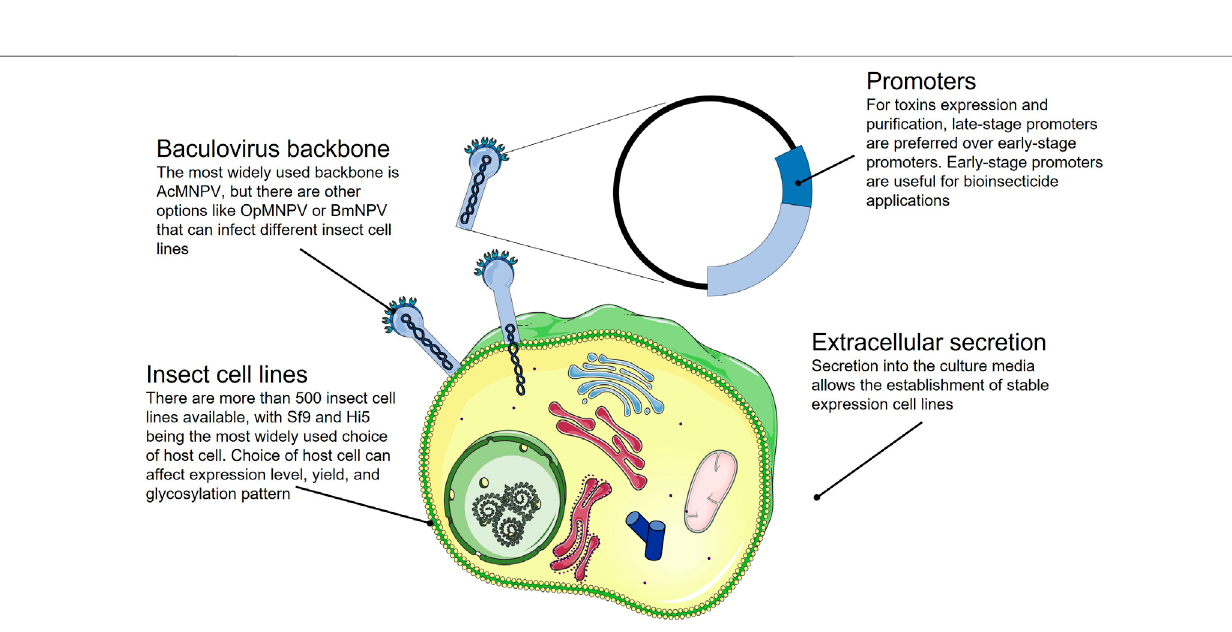
Frontiers in Bioengineering and Biotechnology |